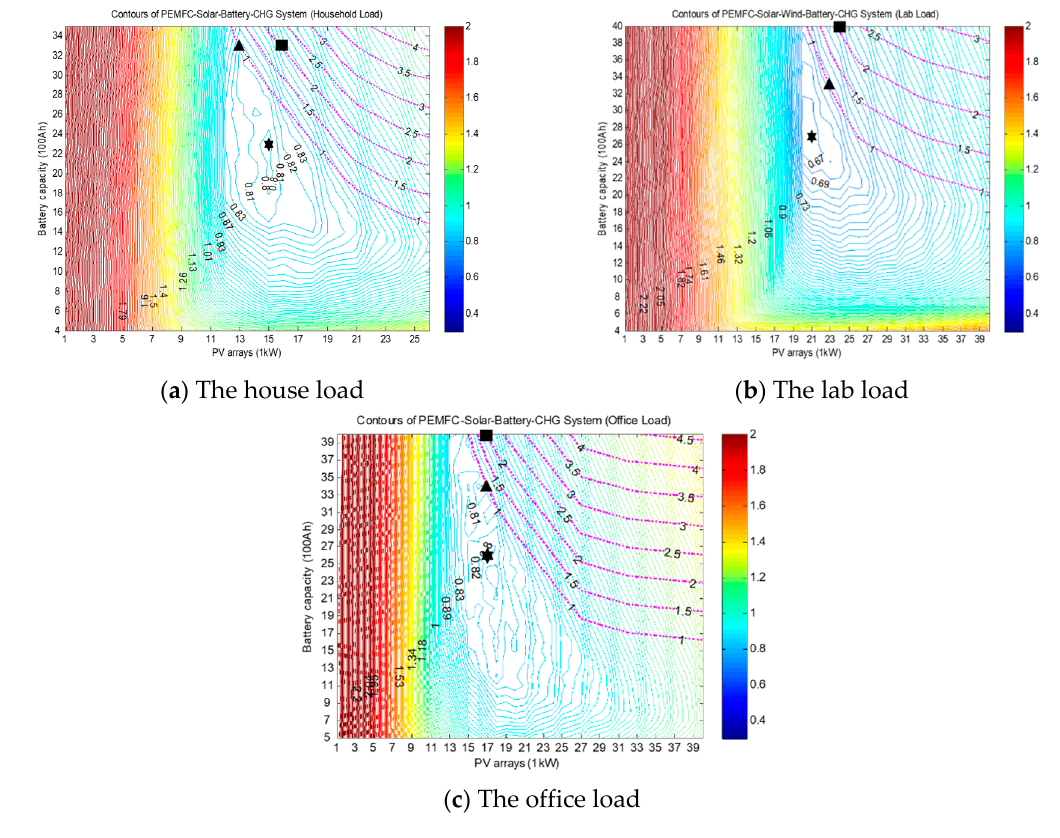
Figure 9. The reference plots with safety consideration. Table 9. Safety analyses.